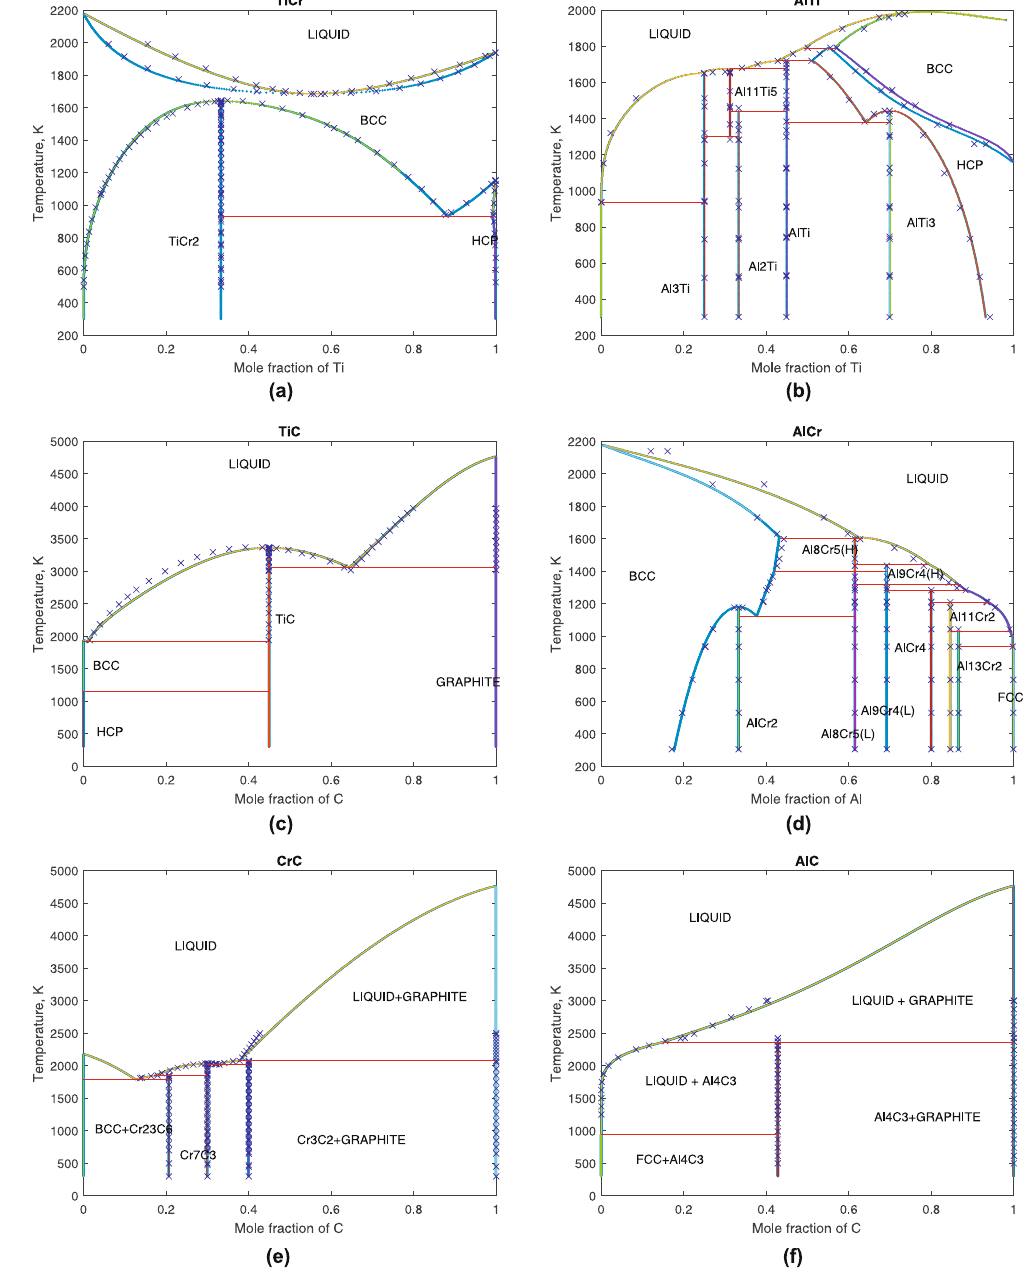
Figure 1. Calculated phase diagram of the binary systems. Here, the (blue) cross indicates phase equilibria data derived from the TCFE7 database, with off-stoichimetric data reduced to stoichiometric for the sake of